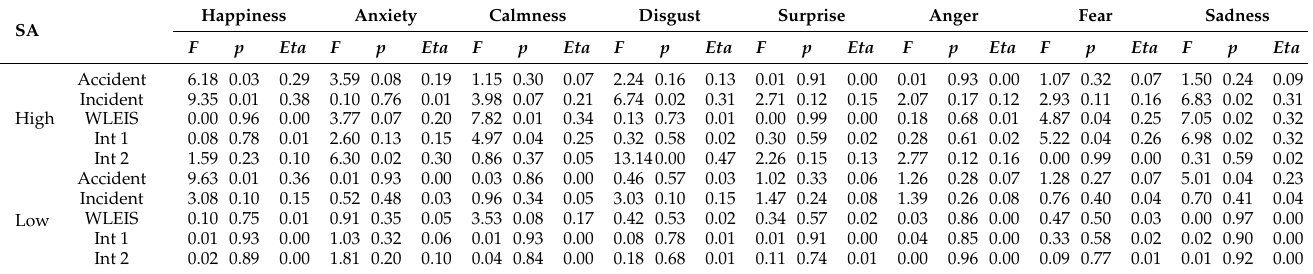
Table 1. Effect of Pilot’s Emotional Intelligence on the Rate of Emotional Change After